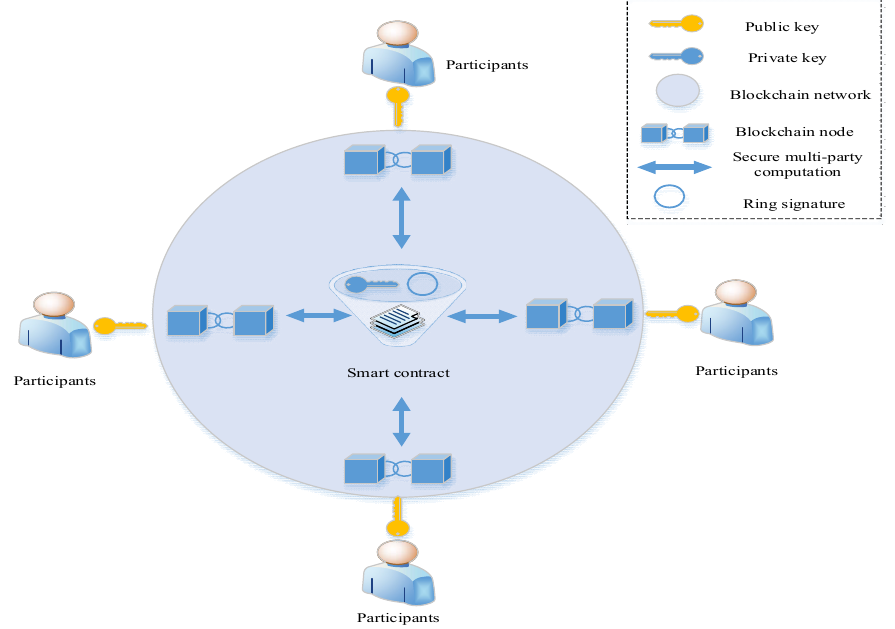
Figure 4. A representative ring signature.